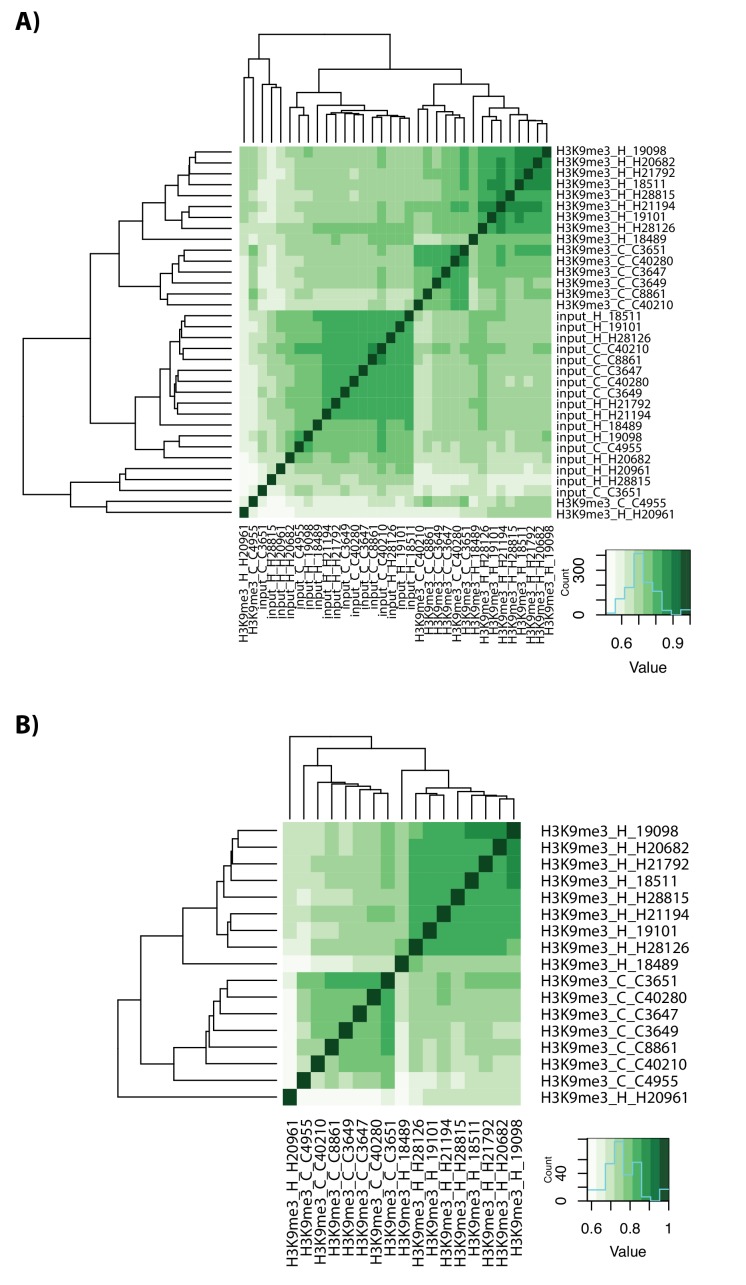
ChIP-seq data clusters by species.(A) Spearman correlation of ChIP-seq read counts for H3K9me3 ChIP and Input samples from human (H) and chimpanzee (C) in 160,113 autosomal regions. (B) Spearman correlation of ChIP-seq read counts for H3K9me3 ChIP samples only in human and chimpanzee.